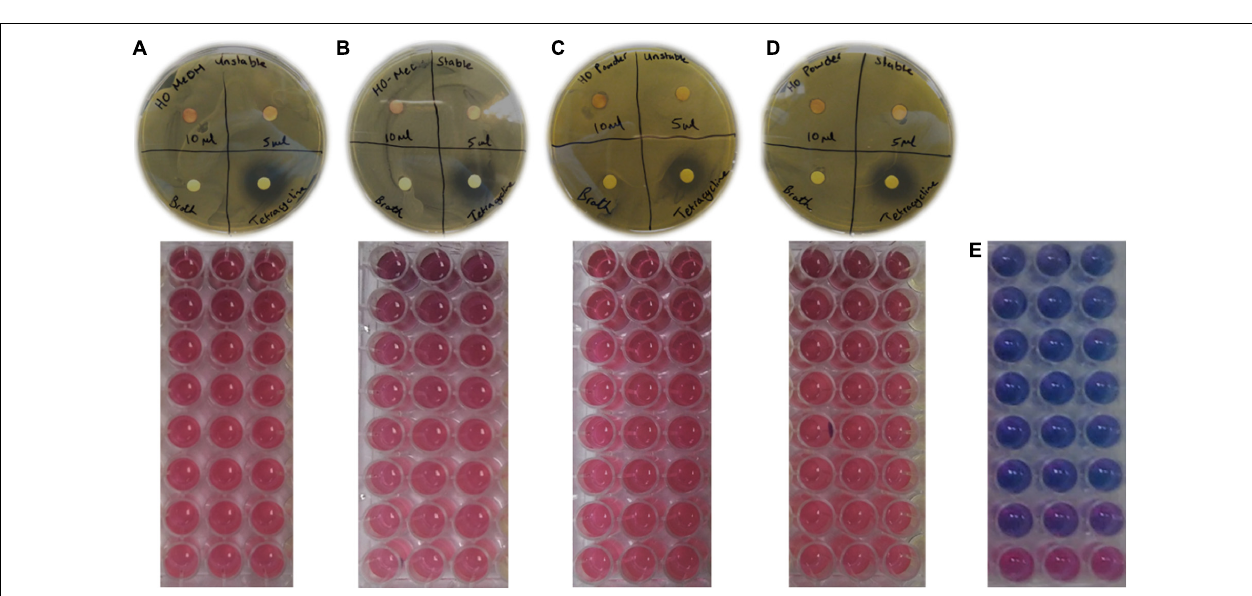
FIGURE 8 | Zeta-potential of Helichrysum odoratissimum methanol extract (A) and H. odoratissimum leaf powder gold nanoparticles (B) gold nanoparticles. *** Is representative of the significance where p -value: p < 0.001.